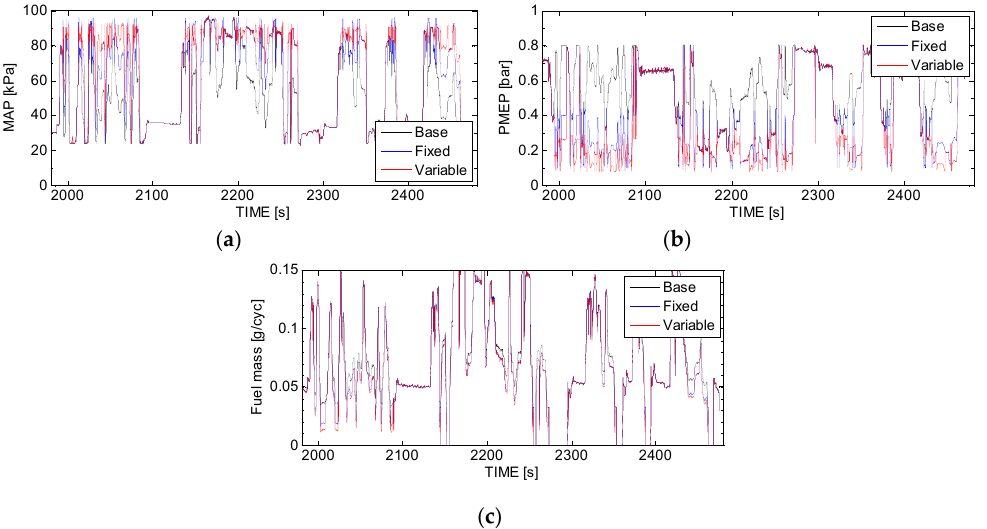
Figure 4. Comparison of results MAP between base engine and cylinder deactivation engine in phase 3 of FTP-75; ( a ) MAP; ( b ) PMEP; ( c ) fuel mass.